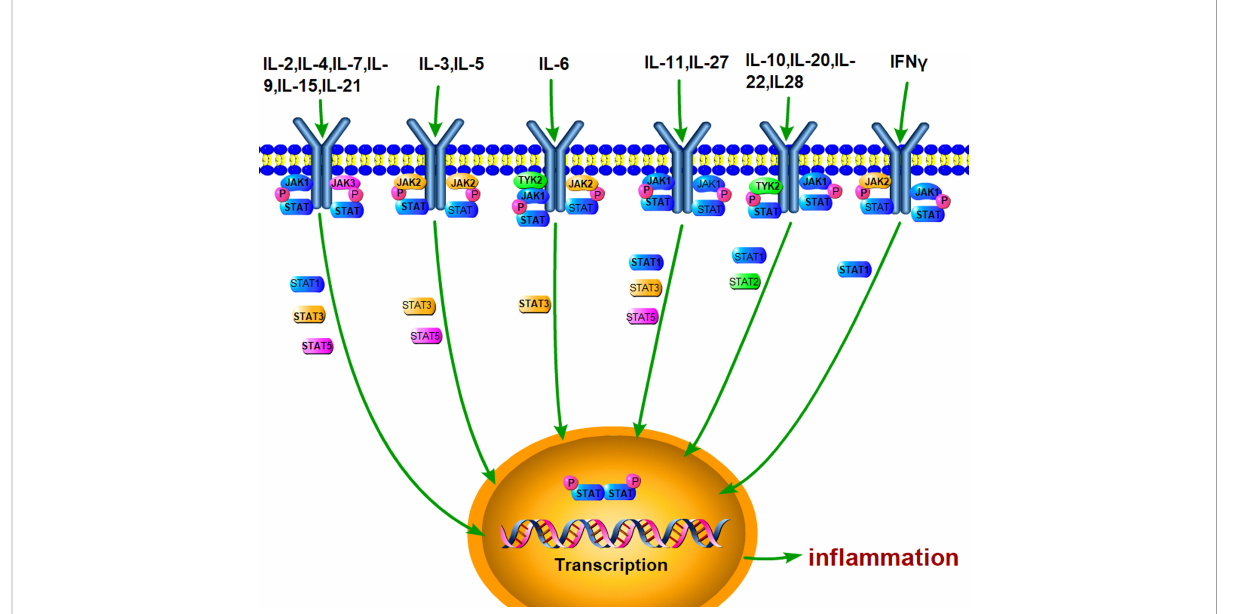
FIGURE 1 JAK/STAT pathway can be stimulated by various cytokines. A lot of extracellular cytokines, such as IL-6, IL-4, and IL-10, can interact with the speci fi c receptors, which phosphorylate JAKs and recruit STAT. Activated STAT forms dimer and enter the nucleus for mediating the transcriptional expression of target genes, such as in fl ammatory